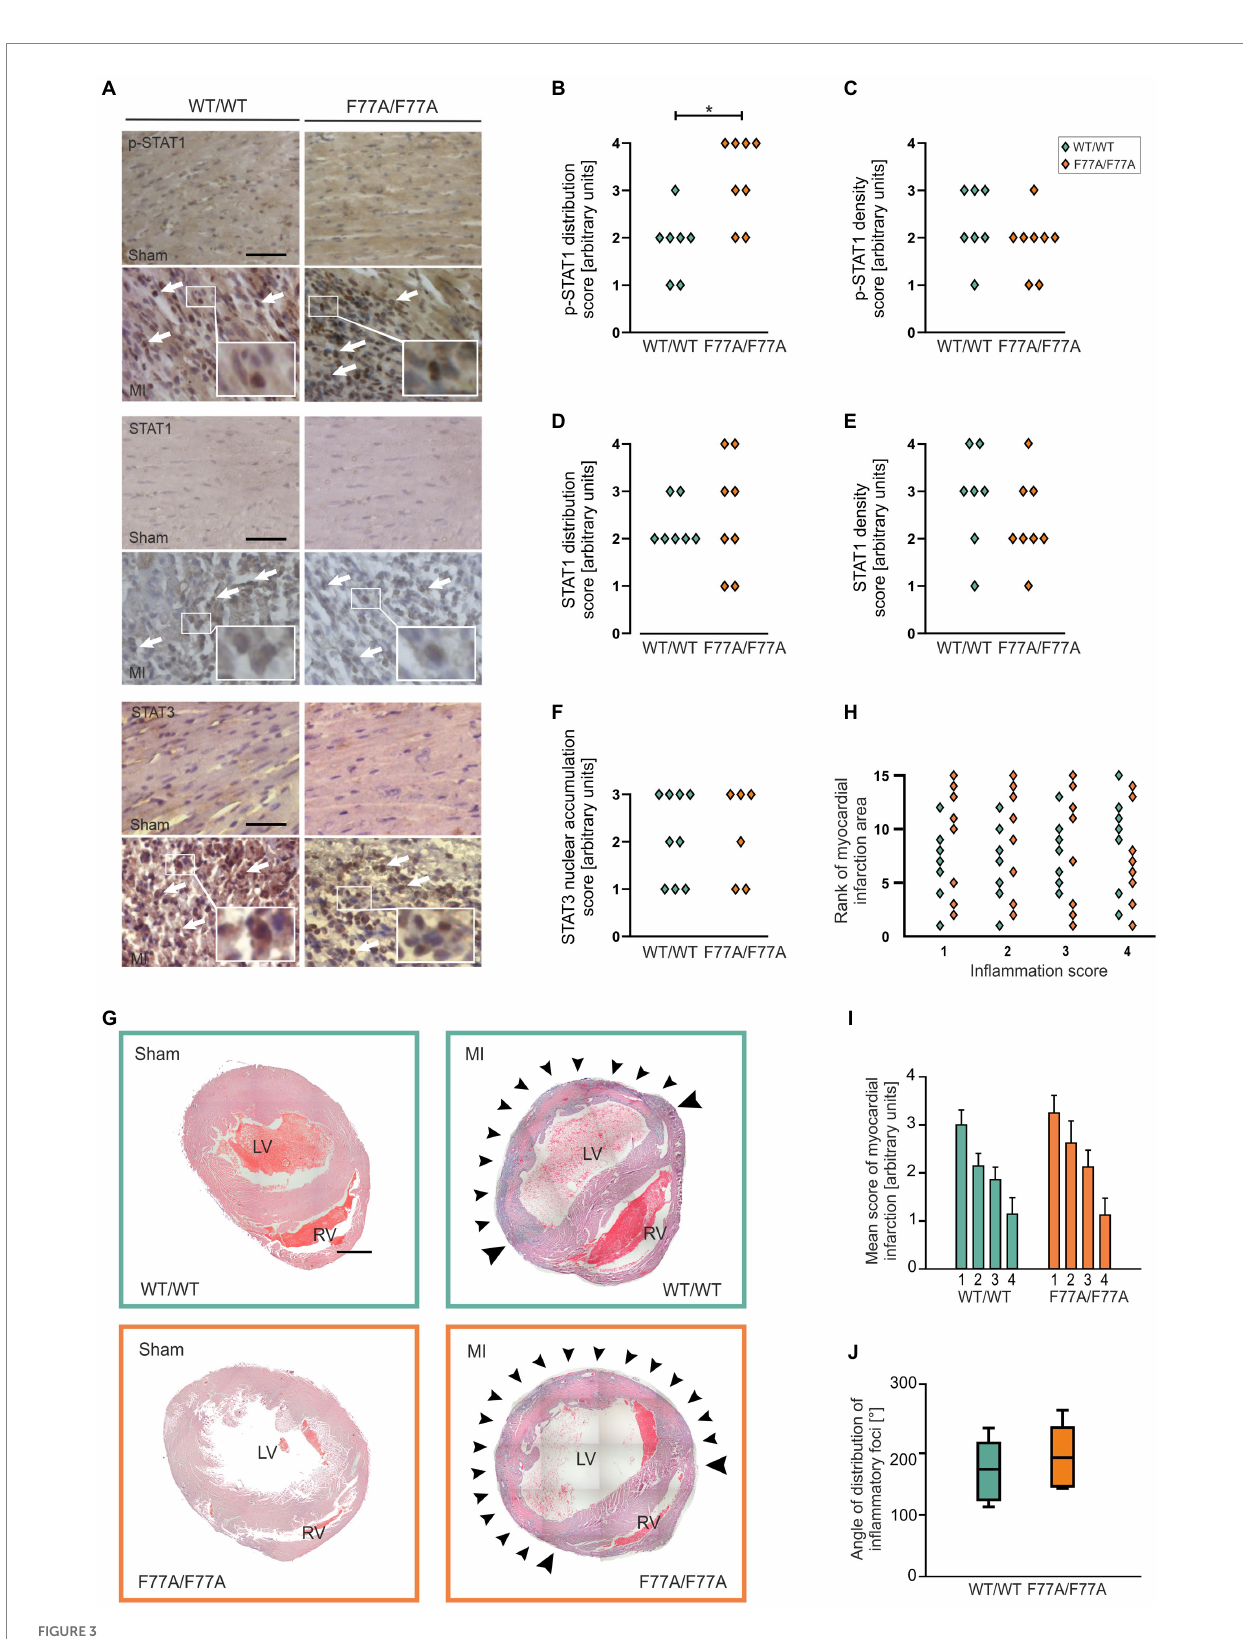
FIGURE 3 A pronounced accumulation of infiltrating phospho-STAT1-expressing cells in the myocardium after MI, as assessed by means of histological analysis. (A – G) Immunohistochemical staining of p-STAT1, STAT1 and STAT3 in heart sections on day 3 after MI or sham operation. (A) Representative micrographs of the left ventricular wall of sham-(top panel) and MI-operated animals (bottom panel) in mice carrying the WT/WT and F77A/F77A genotype, respectively (scale bar: 50 μm). Arrows mark individual cells with positive immunohistochemical staining for the indicated